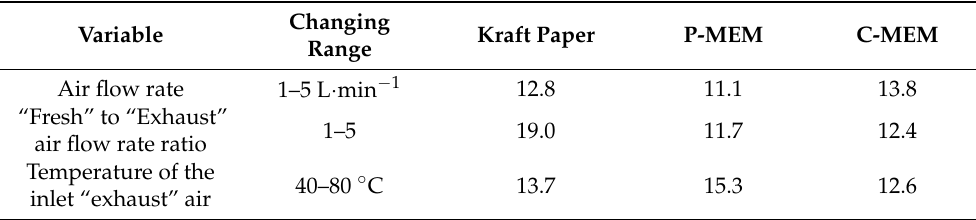
Table 3. The average percentage of error for each set of experiments under different operational